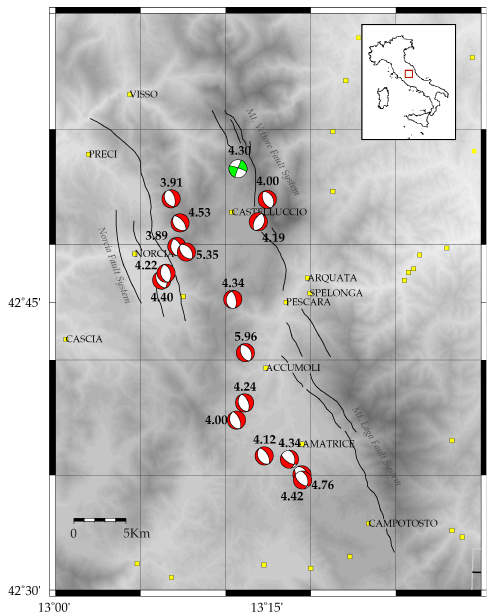
Figure 1 : Location map of the study area in which are represented the focal mechanism data with Mw ≥ 3.9 re- lated to the Amatrice seismic sequence, red and green colours represent normal and strike-slip faulting regime, respectively; the numbers close to the beach-balls are re- lated to the Mw values associated [Scognamiglio et al., 2016]. The black lines are the main fault systems [Cen- tamore et al., 1992; Pierantoni et al., 2013]. Yellow squares indicate some